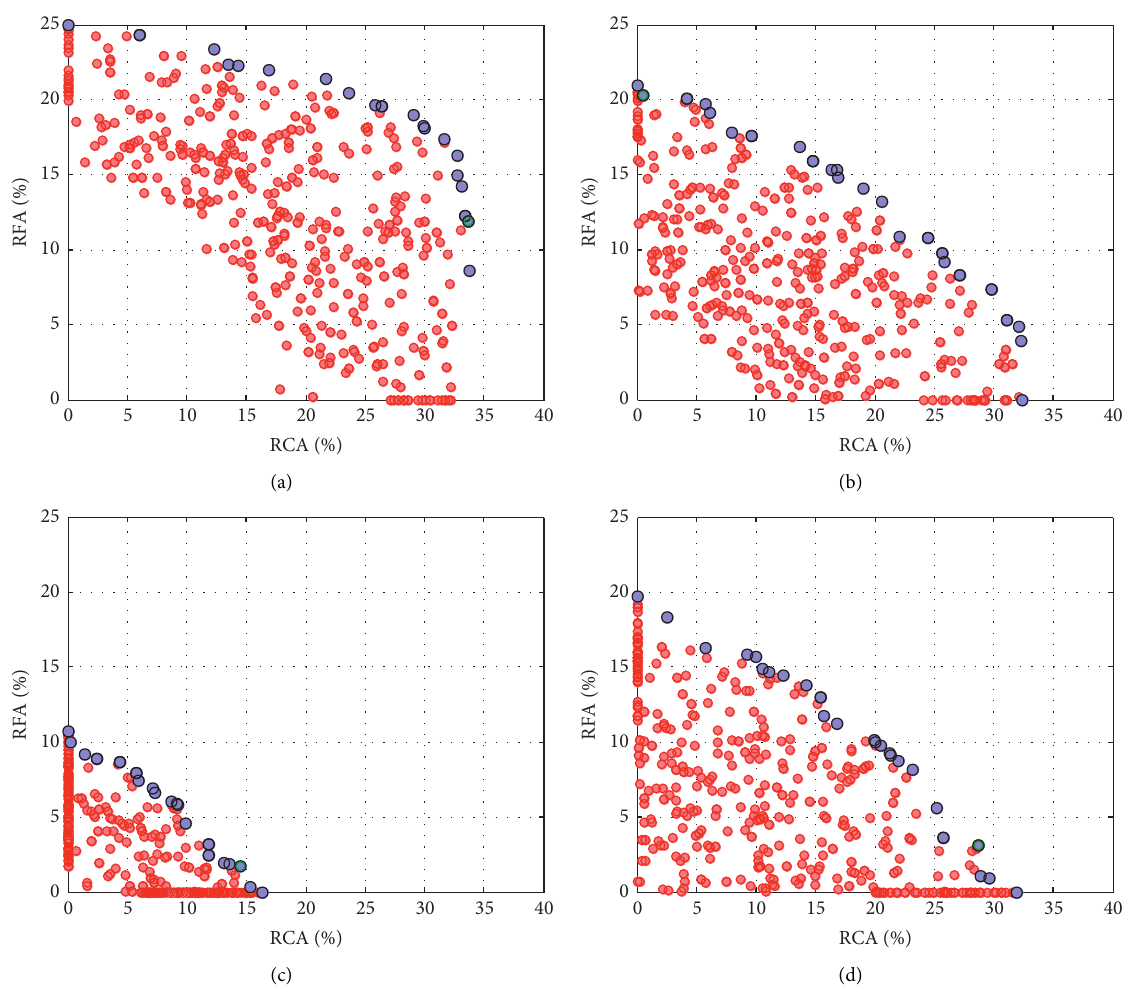
Figure 22: MOEDA-WSM RBDO result for different environment condition. (a) T � 23 ℃ , rh � 70%, C ℃ , rh � 70%, C ρ thr � 80 Ω .m